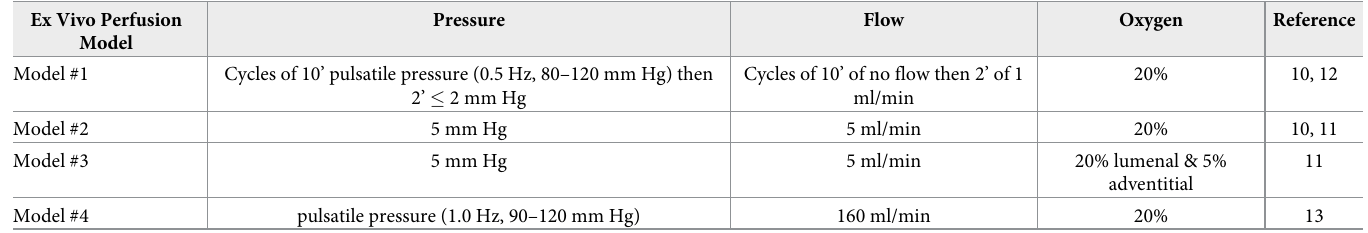
Table 1. Ex vivo vein perfusion